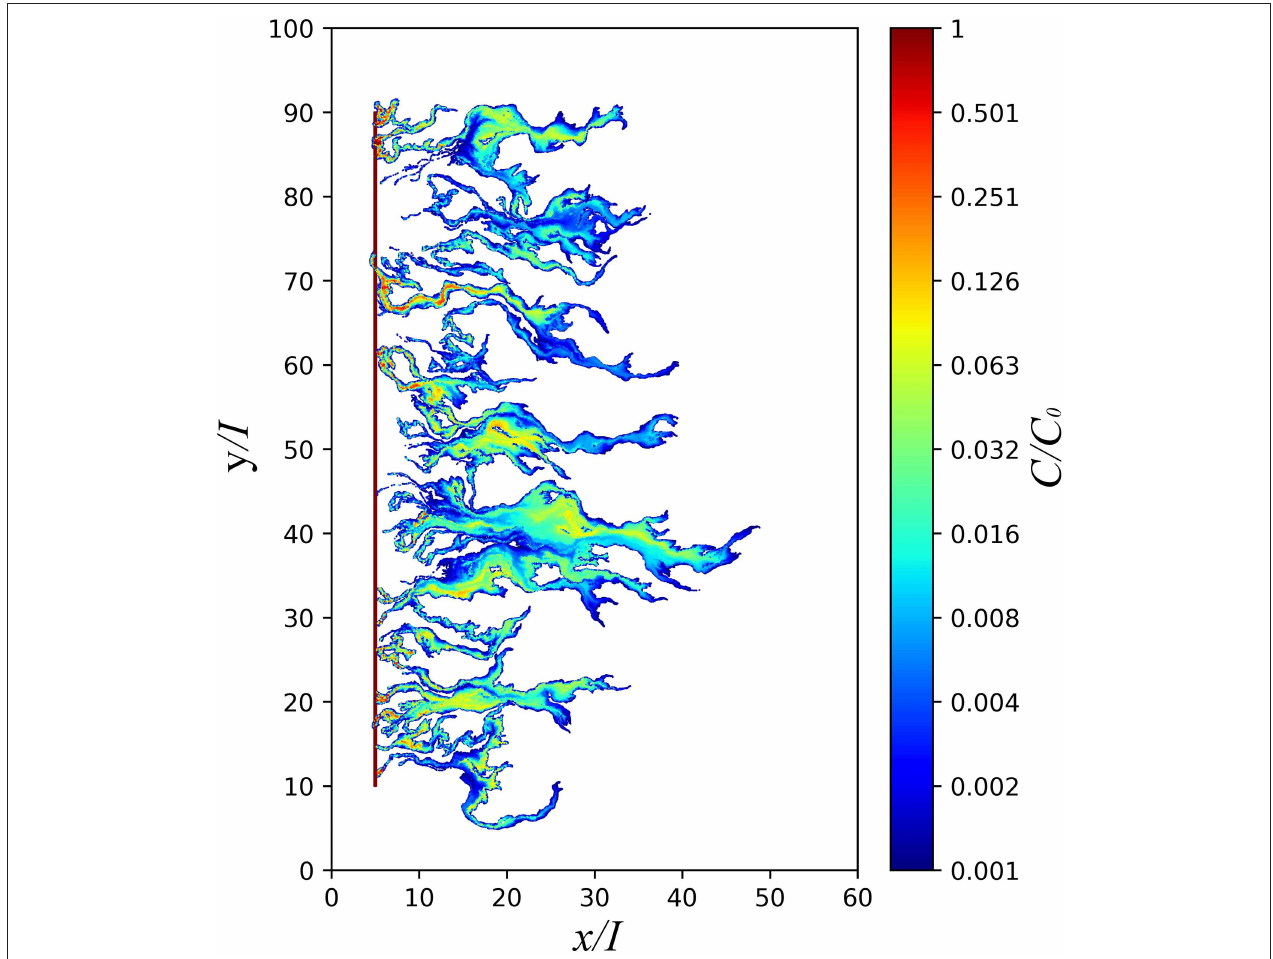
FIGURE 2 | Numerically simulated concentration field (in 2D) after an instantaneous injection within a thin (linear) source perpendicular to mean flow (indicated by a red vertical line at x / I = 5, with I the longitudinal integral scale of logconductivity), of dimensions L y = 80 I and L x = 0.25 I at time tU / I = 10; the other parameters are σ 2 Y = 6 and Pe = I /α dL = 1000. The plume is seemingly erratic, with clear fingering patterns and stagnant